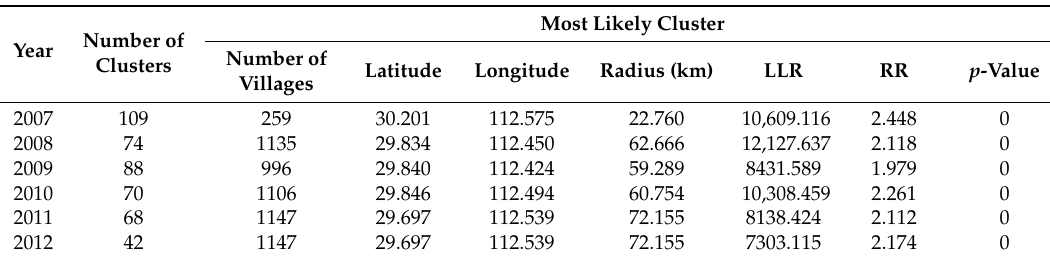
Table 1. Spatial analysis scanning for clusters with large populations of schistosomiasis infections using Kulldorff’s spatial scan statistic.